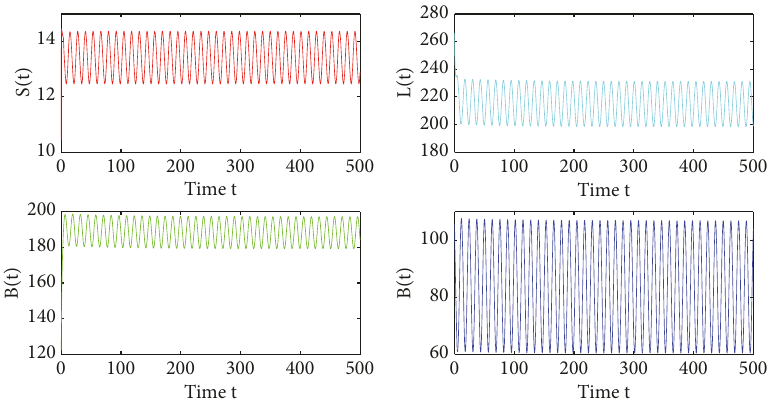
Figure 4: Time plots of 𝑆 , 𝐿 , 𝐵 , and 𝑅 with 𝜏 = 3.6755 > 𝜏 0 = 3.4685 .